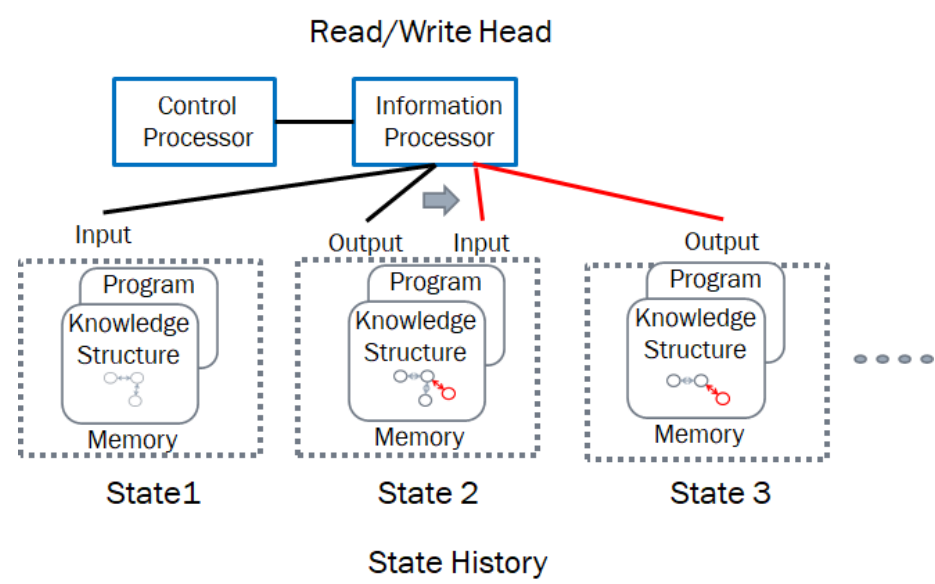
Figure 7. The schema with a triadic automaton represents a knowledge structure containing various object, inter-object, and intra-object relationships and behaviors, which emerge when an event occurs, changing the objects or their relationships.